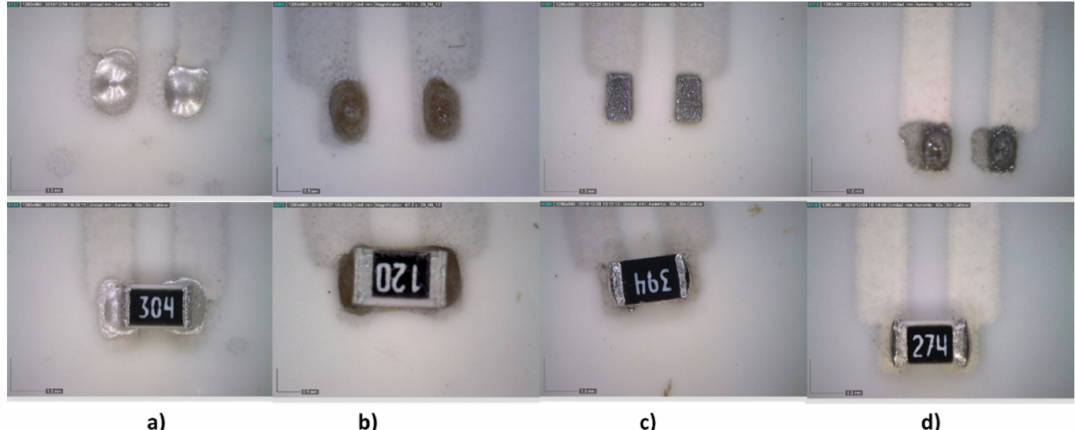
Figure 13. Stencil printing of pastes/adhesives on solder reflow footprint. Above: after printing; below: after temperature